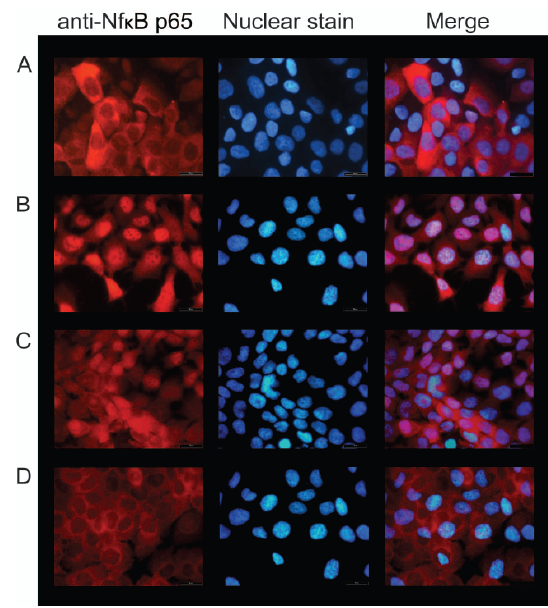
Figure 3. Inhibition of TNF- α induced NF- κ B activation and nuclear translocation by Radix Scrophulariae ningpoensis